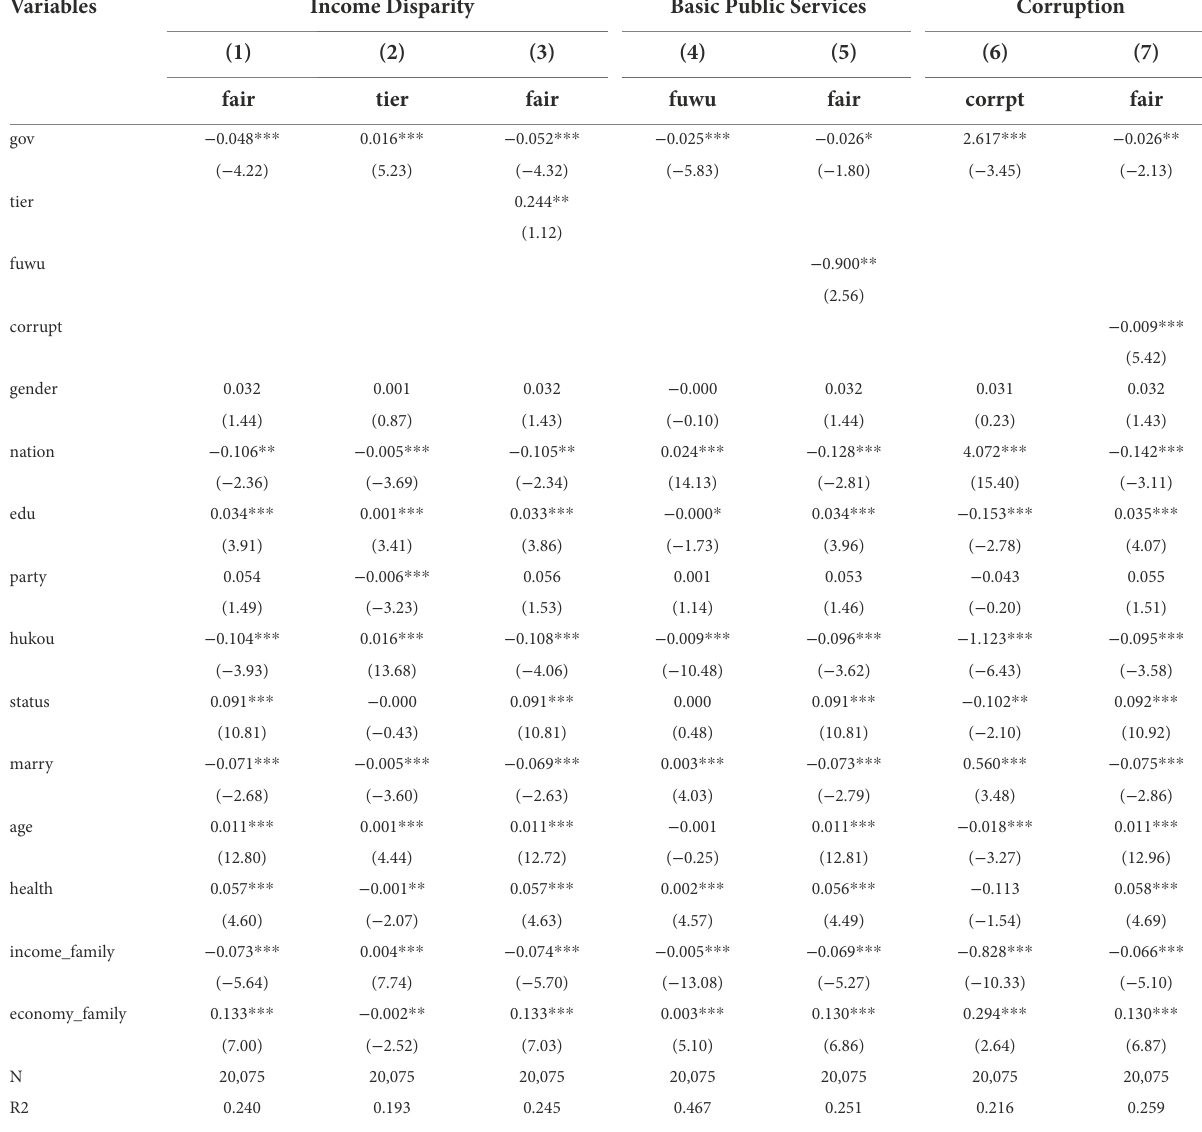
TABLE 5 Results of testing the mechanism of the intrinsic effect of local government competition on residents’ perceptions of social fairness.